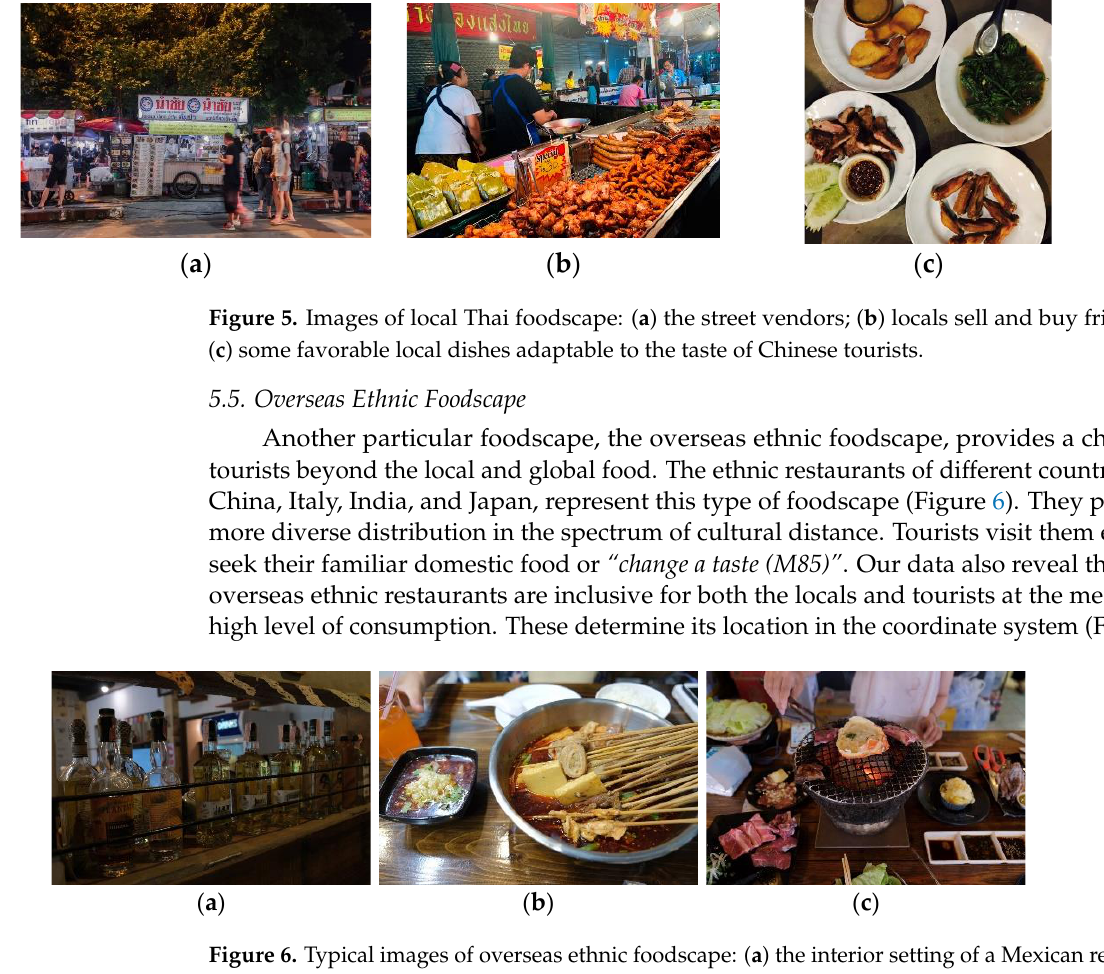
Figure 5. Images of local Thai foodscape: ( a ) the street vendors; ( b ) locals sell and buy fried meat; ( c ) some favorable local dishes adaptable to the taste of Chinese tourists.